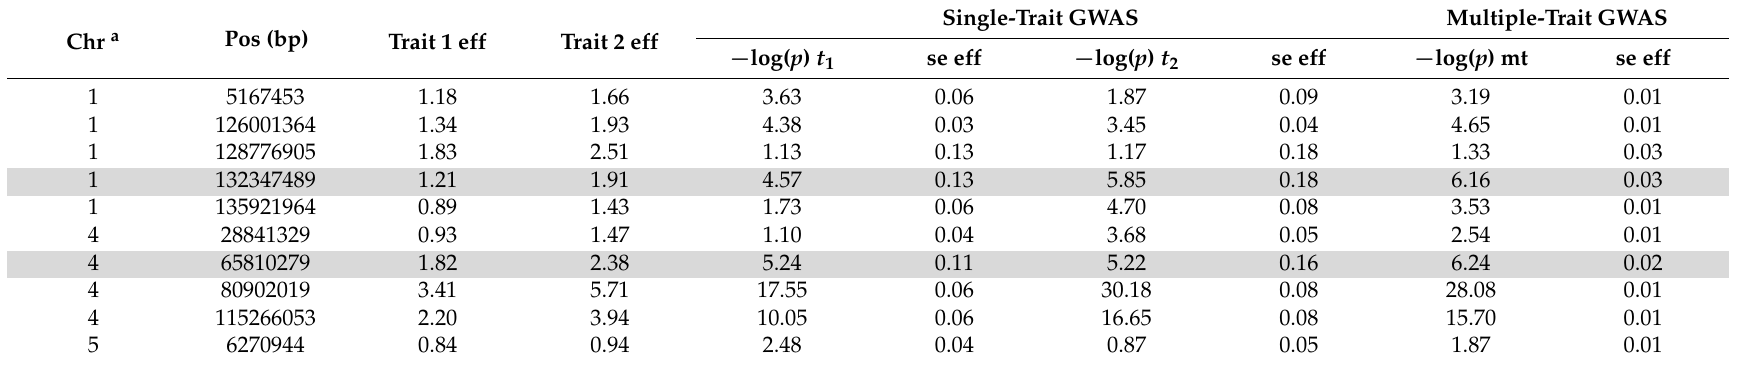
Table 1. Positions, effects, and p -Values of ten quantitative trait nucleotides (QTNs) based on simulated data without environmental